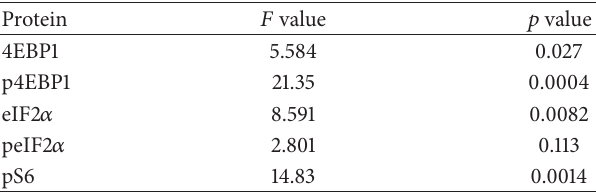
Table 1: One-way ANOVA 𝐹 and 𝑝 values comparing fold change in signal intensity for target proteins measured across each group (3-week, 7-week,